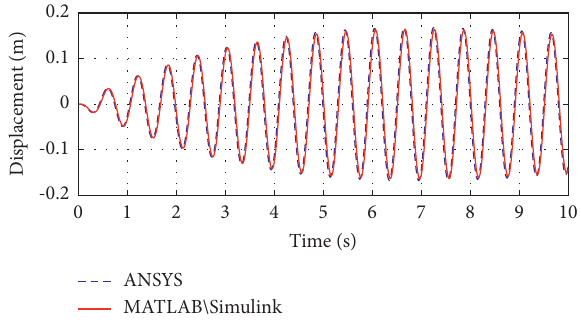
Figure 5: : Displacement of a single DOF structure controlled by PTMD.